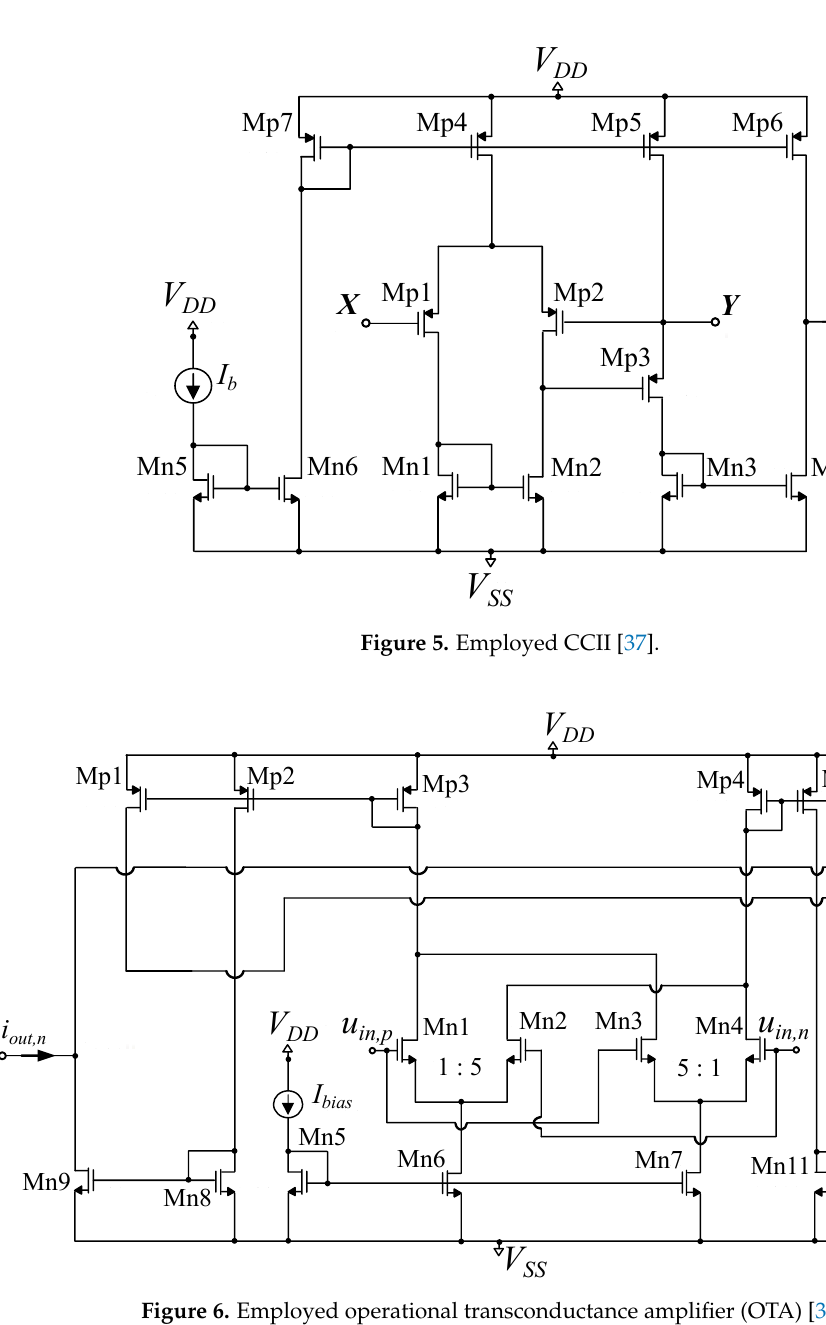
Figure 6. Employed operational transconductance amplifier (OTA)